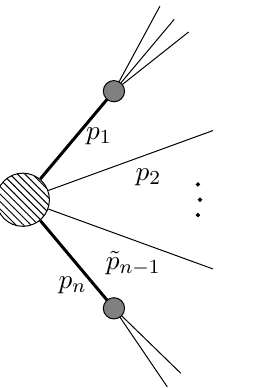
Figure 1. Sketch of a (cid:12)nal-collinear mapping with two simultaneous clusters of particles mapped respectively to ~ p 1 and ~ p n . We denote o(cid:11)-shell parent momenta with a thick line and their on-shell mapped version with a wavy